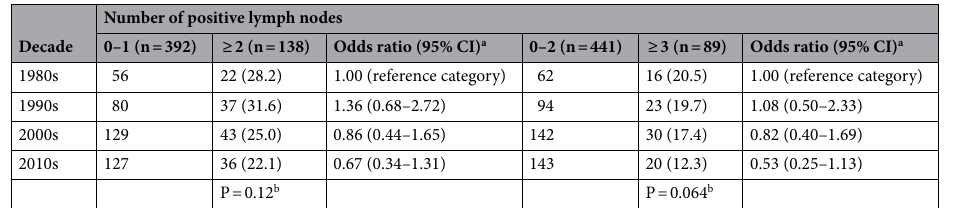
Table 3. Association of time period with the number of positive lymph nodes in patients with vulvar squamous cell carcinoma living in northern Italy. Analysis was restricted to patients undergoing lymph node dissection (n = 530). a Simultaneously adjusted for patient age, tumour size, disease location, depth of stromal invasion and number of lymph nodes dissected. b Chi-square test for trend. CI, confidence interval.